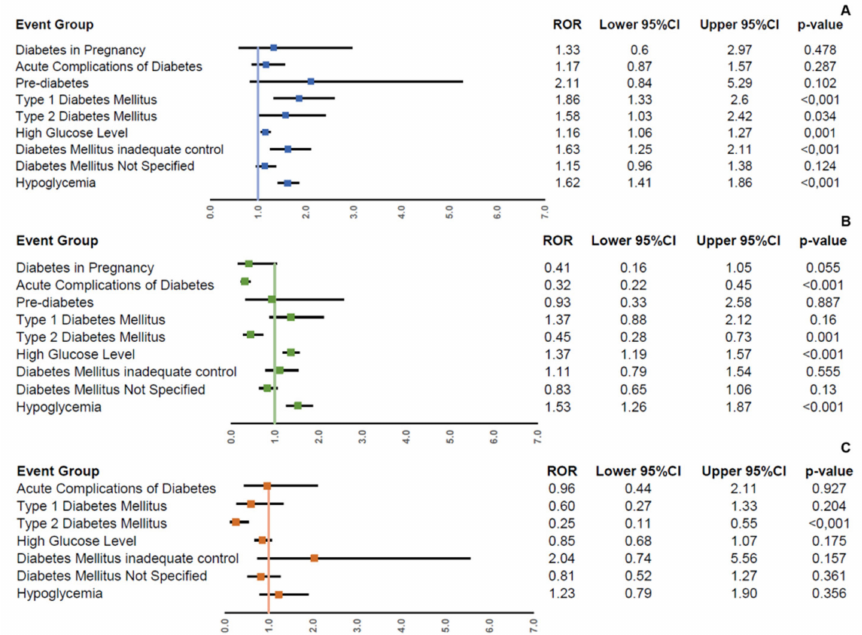
Figure 3. Reporting frequency of impaired glucose metabolism groups among COVID-19 vaccines. Reporting odds ratios (RORs) and their 95% confidence interval (95% CI) of impaired glucose metabolism groups comparing COVID-19 mRNA vaccines with COVID-19 viral vector-based vaccines ( A ), Pfizer–BioNTech vaccine with Moderna vaccine ( B ), and Oxford–AstraZeneca vaccine with Janssen vaccine ( C ) in all Individual Case Safety Reports (ICSRs) reported in Eudravigilance